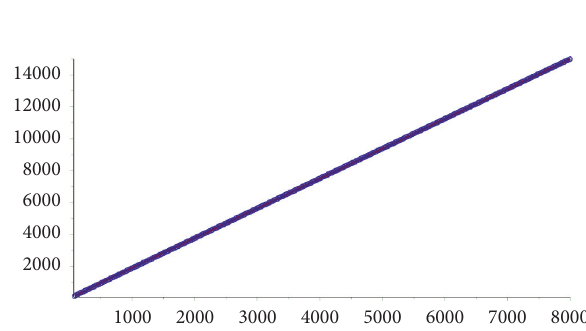
� √ ��� √ � √ n ) /12 h ( n ) − n 3/2 ) and the fitting curve C 2 2/3